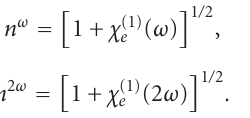
where λ is the wavelength of the fundamental wave in nm and n ω , n 2 ω are refractive index at fundamental and second harmonic wavelengths. n ω and n 2 ω values of L-threonine were found out with the help of the following equations.